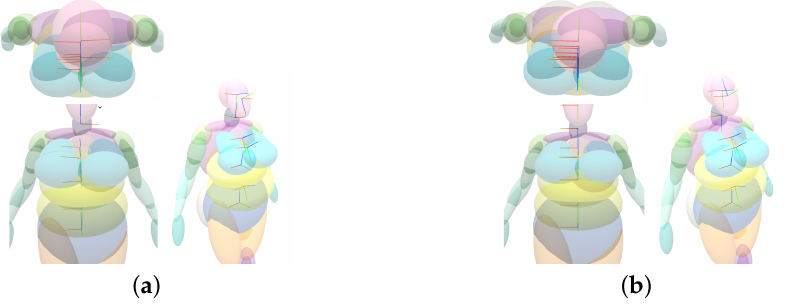
Figure 14. Correction of central ellipsoid symmetry of ellipsoids from Tall Chubby. ( a ) Asymmetric model. ( b ) Symmetric model.